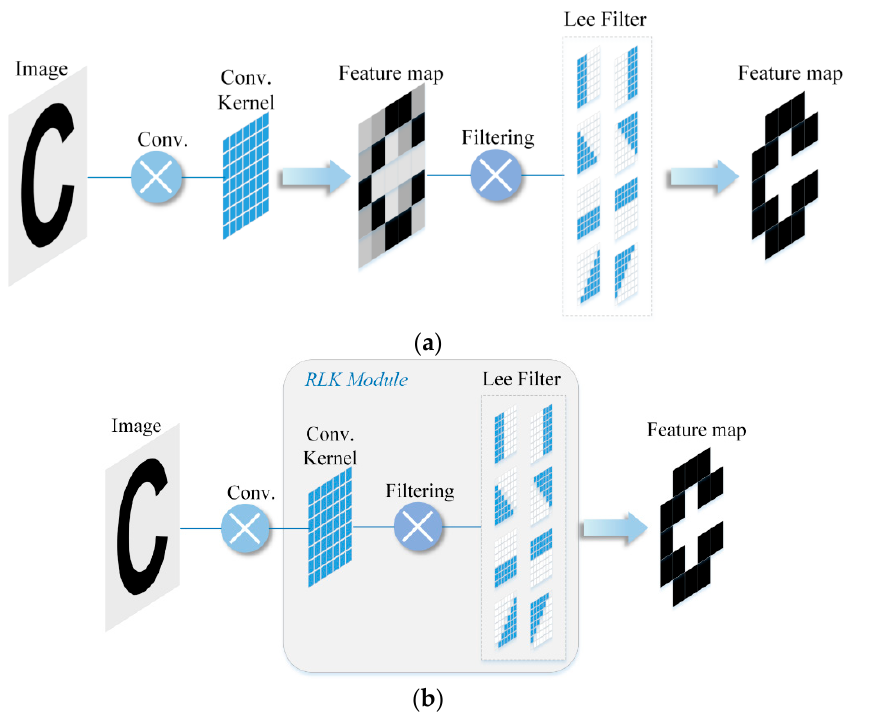
Figure 8. RLK module (Reprinted from Ref. [135]. 2021, Zhishun Guo). ( a ) The general process of filtering feature maps. ( b ) Schematic diagram of RLK module.